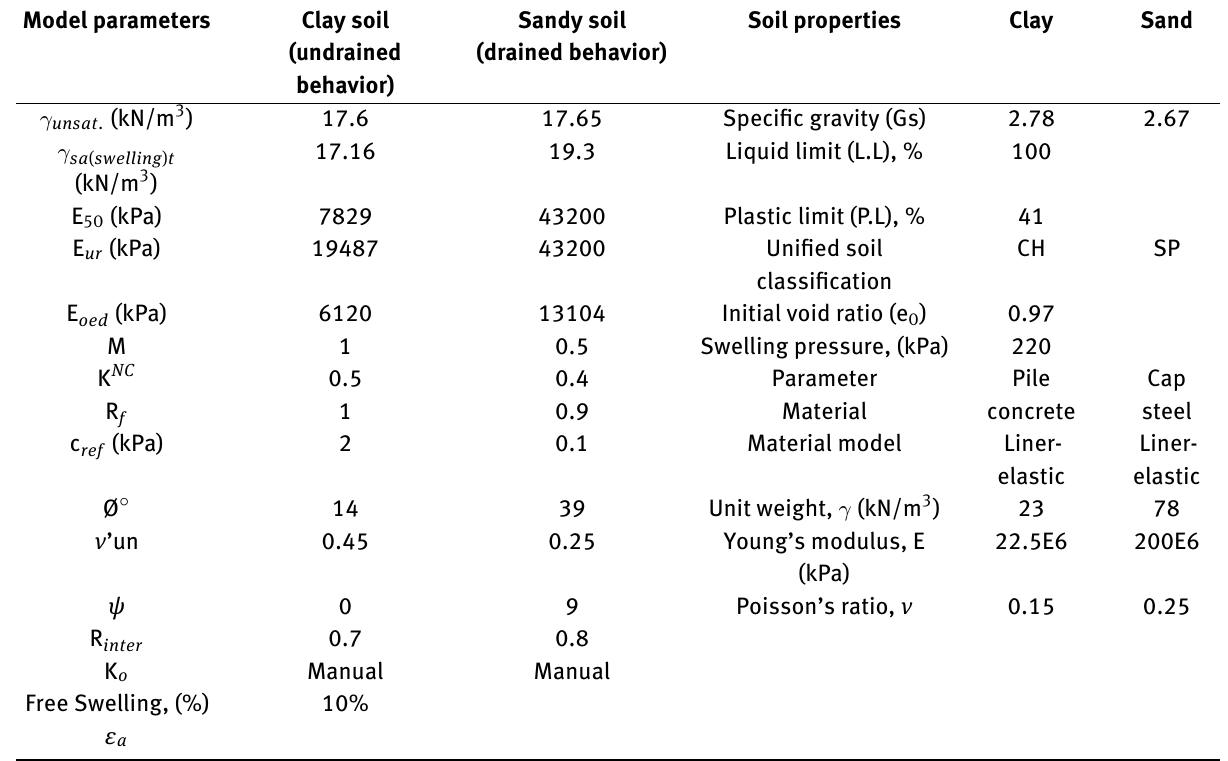
Table 1: Soil and pile properties considered in finite element analysis Model